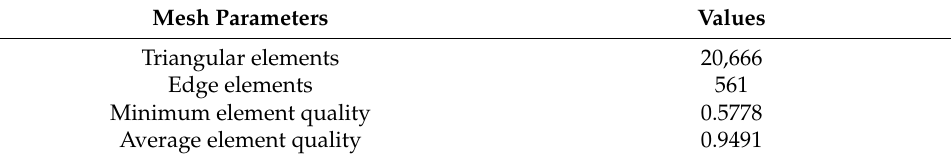
Table 1. Table of mesh parameters.